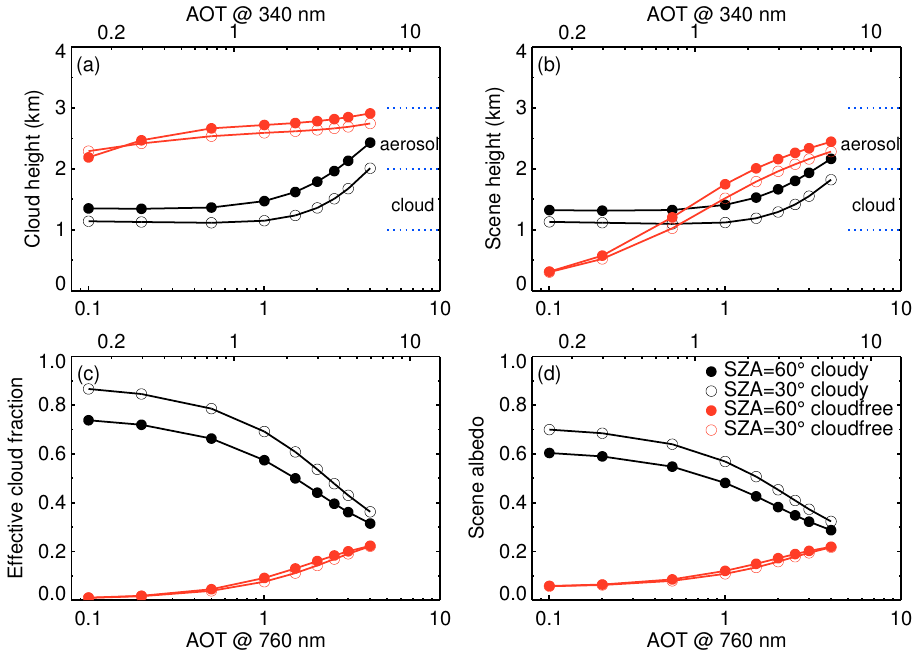
Fig. 7. Same as Fig. 5 but for the location of the dust aerosol layer between 2 and 3km.